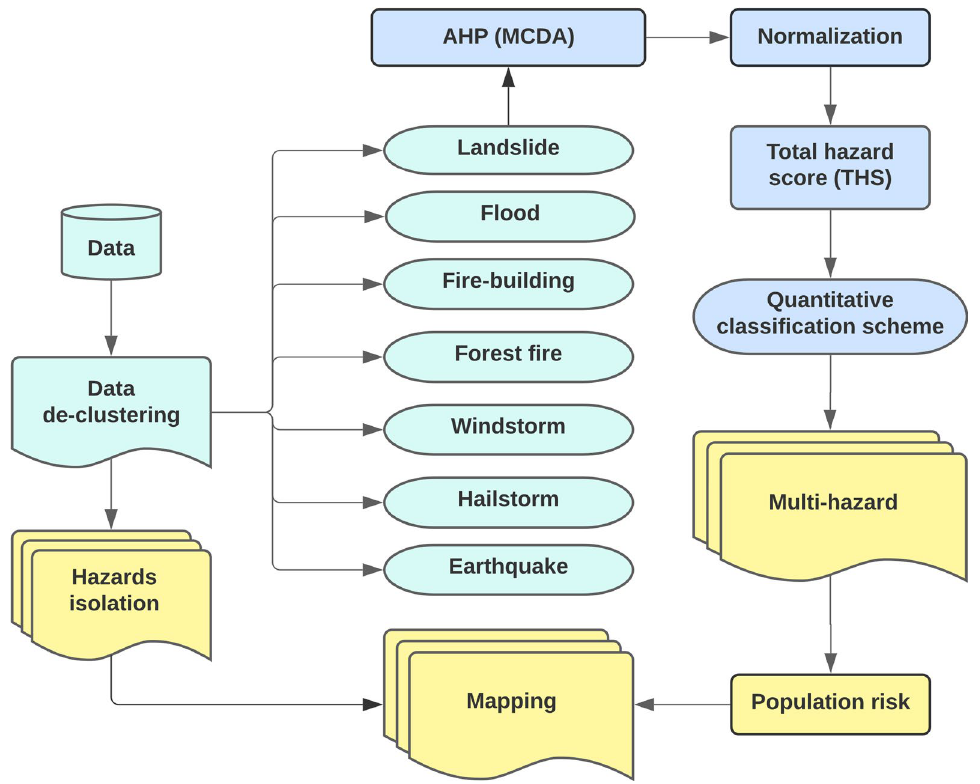
Fig. 2 Implementation of the methodology